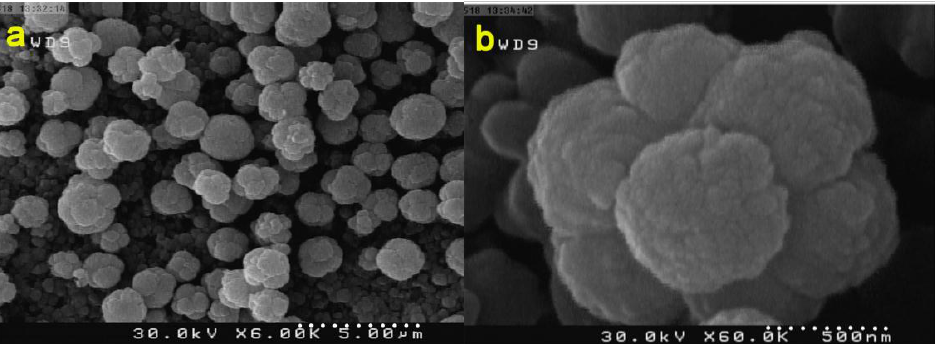
Figure 6. SEM images for the flower-like ZnO hierarchical nanostructures prepared without any surfactant or stabilizer at different magnifications. ( a ) The results indicate that flower like ZnO structures are partially grown on the CuO film; ( b ) Each mini-sphere contains numerous nanoparticles and the structures are symmetrical with specific shapes. Also, the effects of the surfactants and stabilizers on the final morphology of the 3D ZnO structures were studied. A representative SEM image of the 3D CuO-ZnO hierarchical structures is shown in Figure 7. According to Figure 7a, it is clear that when PEG 6000 is used as the capping agent (Z1 sample), the particles are aggregated and bulk structures are made. The flower like structure has also been destroyed and only micro spheres are obtained. In comparison with the Z0 sample, the microspheres are denser but the mean size of the spheres is approximately the same as